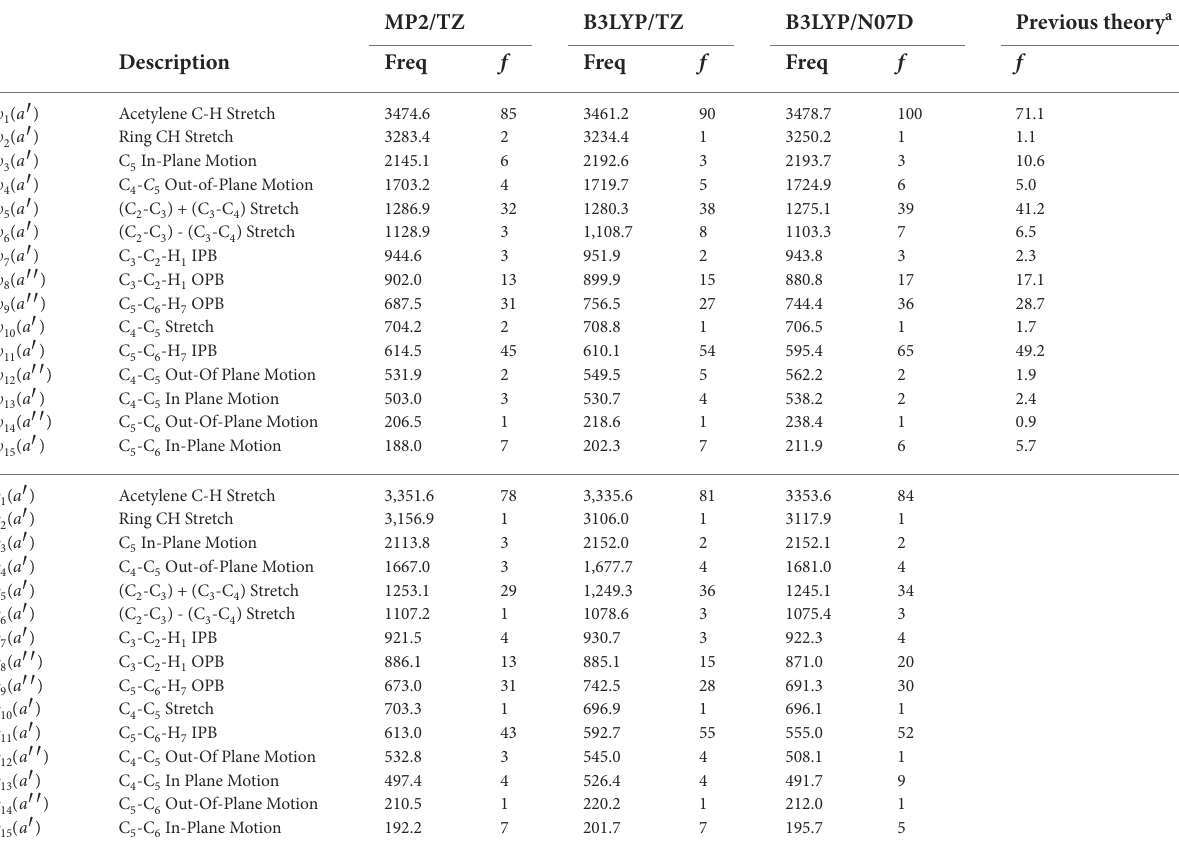
TABLE 7 Intensitiesinkm mol −1 of c -C 3 HC 2 Hcomparedtoprevioustheorycomputedatthefc-CCSD(T)/cc-pVTZleveloftheory a